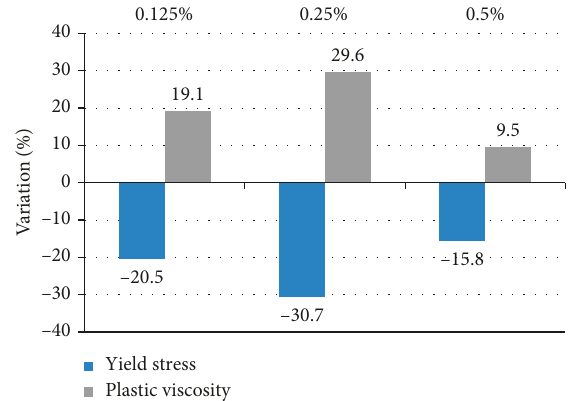
Figure 10: Variation of yield stress and plastic viscosity of nanomodified cement pastes.